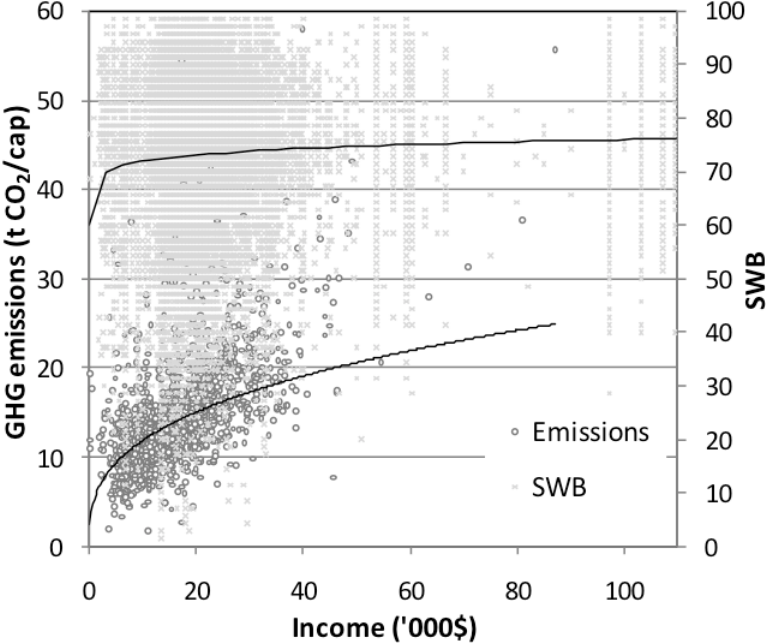
Figure 2. Univariate relationship between income and subjective wellbeing ( SWB) (upper grey × symbols) and greenhouse gas emissions (GHG) emissions (lower black o